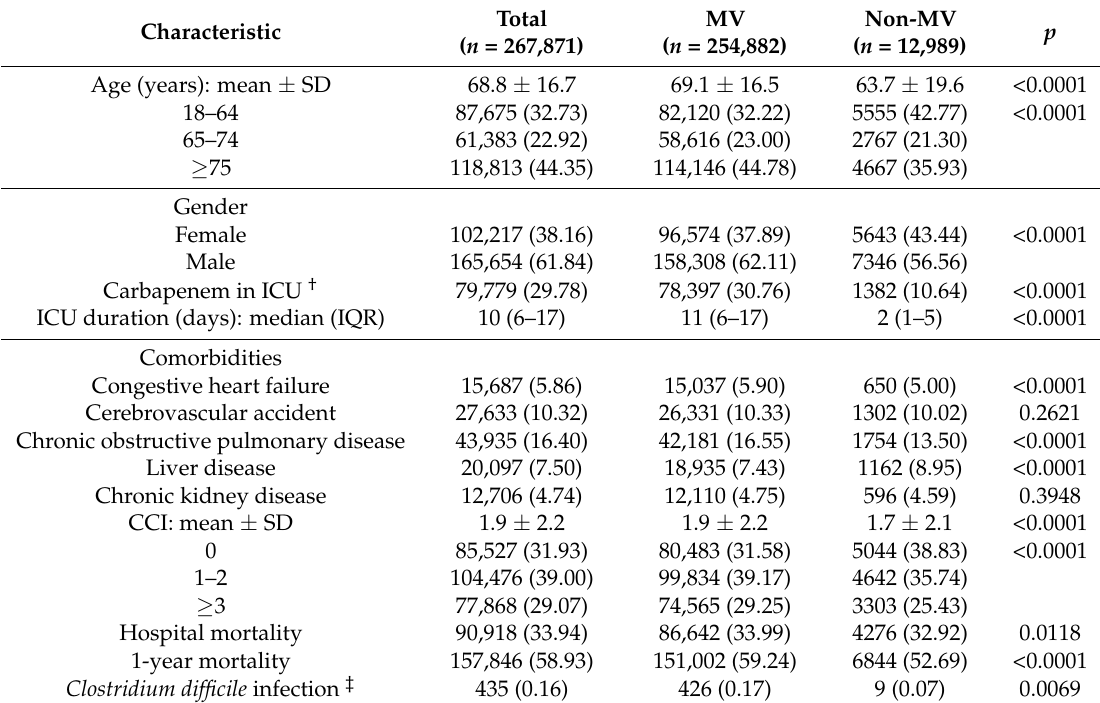
Table 1. The characteristics of the enrolled patients in this